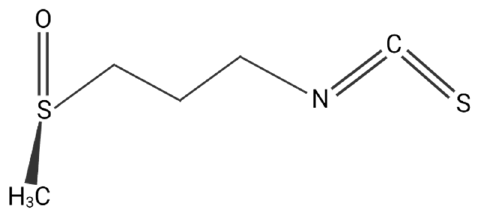
Figure 4. Sulforaphane, basic chemical structure. Created with BioRender.com .